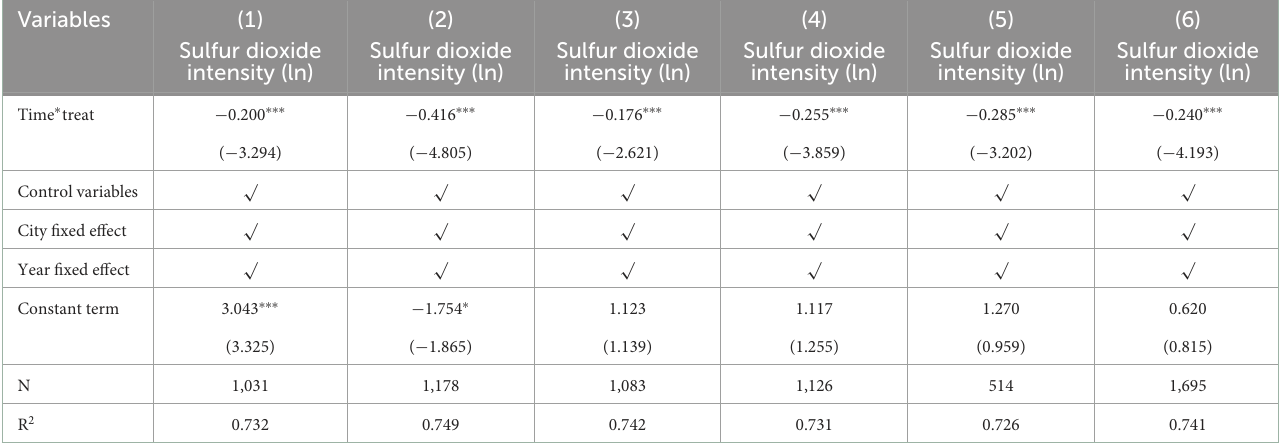
TABLE 8 Heterogeneity analysis.